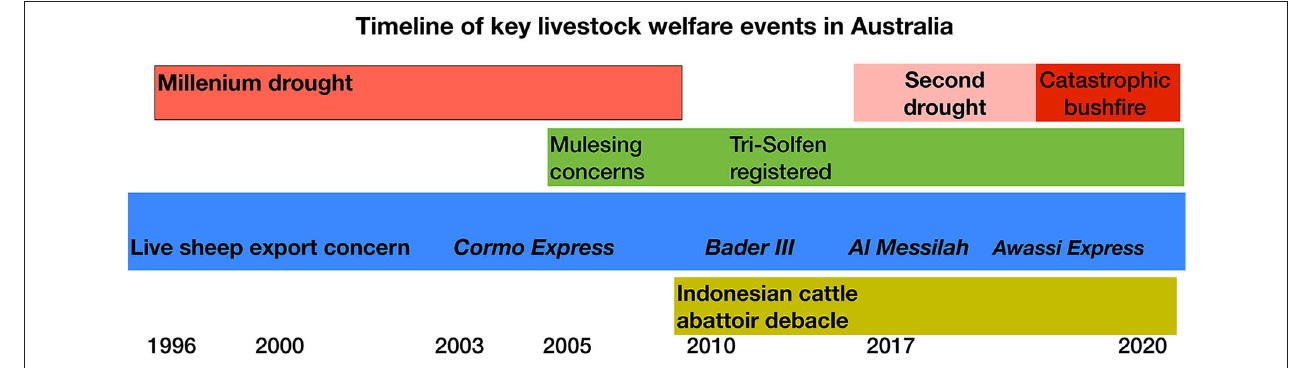
FIGURE 1 | Timeline of key recent livestock adverse welfare events in